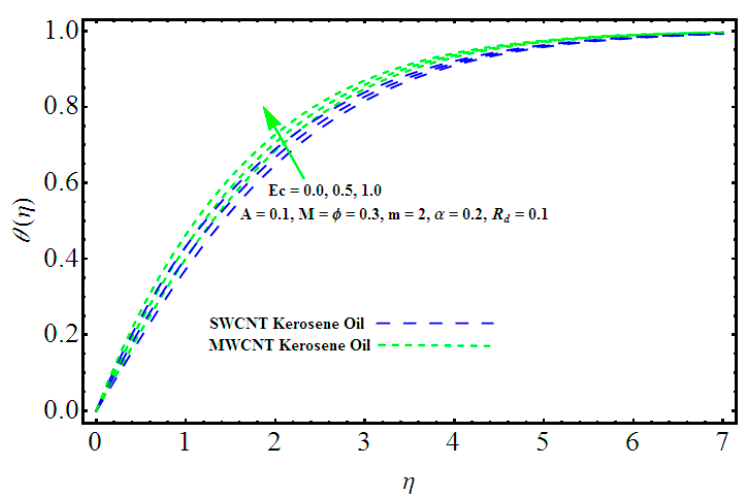
Mathematics 2020 , 8 , x FOR PEER REVIEW